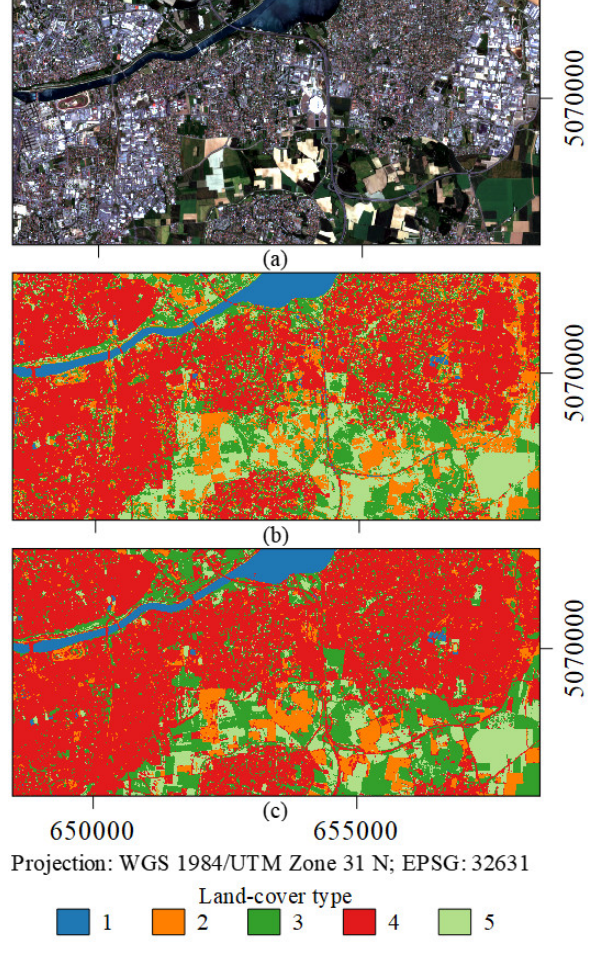
Figure 2. Example subset for a central part of the study area: (a) S2 ‘true color’ composite; (b) XGB classification using single- date S1 and S2 imagery; (c) XGB classification using MT S1 and S2 imagery.